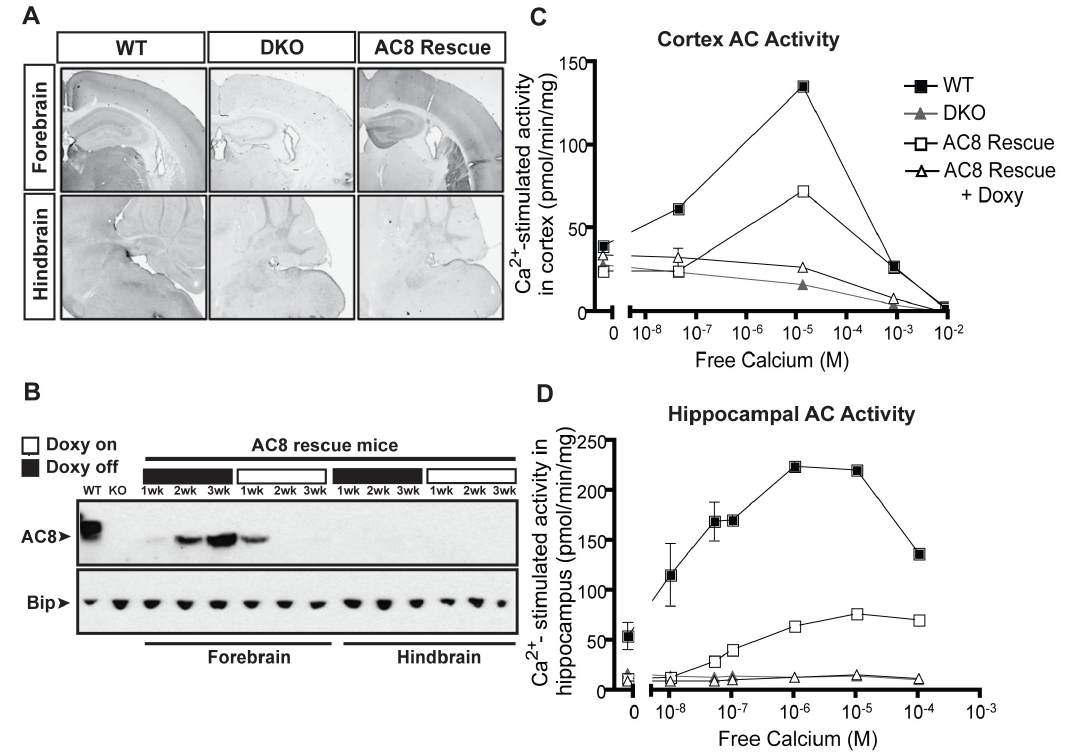
Figure 5. Generation of inducible forebrain-specific AC8 mice on a DKO background. ( A ) Immunohistochemistry results confirm complete absence of AC8 protein levels in DKO mice, while AC8 rescue mice have AC8 replaced within forebrain-specific regions but not in the hindbrain or thalamus. ( B ) Using doxycycline to manipulate AC8 expression within the forebrain, we observed AC8 expression after 2 wk off doxycycline. In contrast, expression begins to rapidly turn off within one week off doxycycline treatment and is undetectable by 2 wk. Hindbrain results reveal no AC8 expression with or without doxycycline treatment. Bip is used as a loading control. The adenylyl cyclase assays in the ( C ) cortex (n=3/genotype) and ( D ) hippocampus (n=3/genotype) reveal no Ca2 + -stimulated activity in DKO mice or AC8 rescue mice on doxycycline, while activity is rescued to approximately 50% ( C ) and 30% ( D ) of WT levels in AC8 rescue mice off doxycycline.